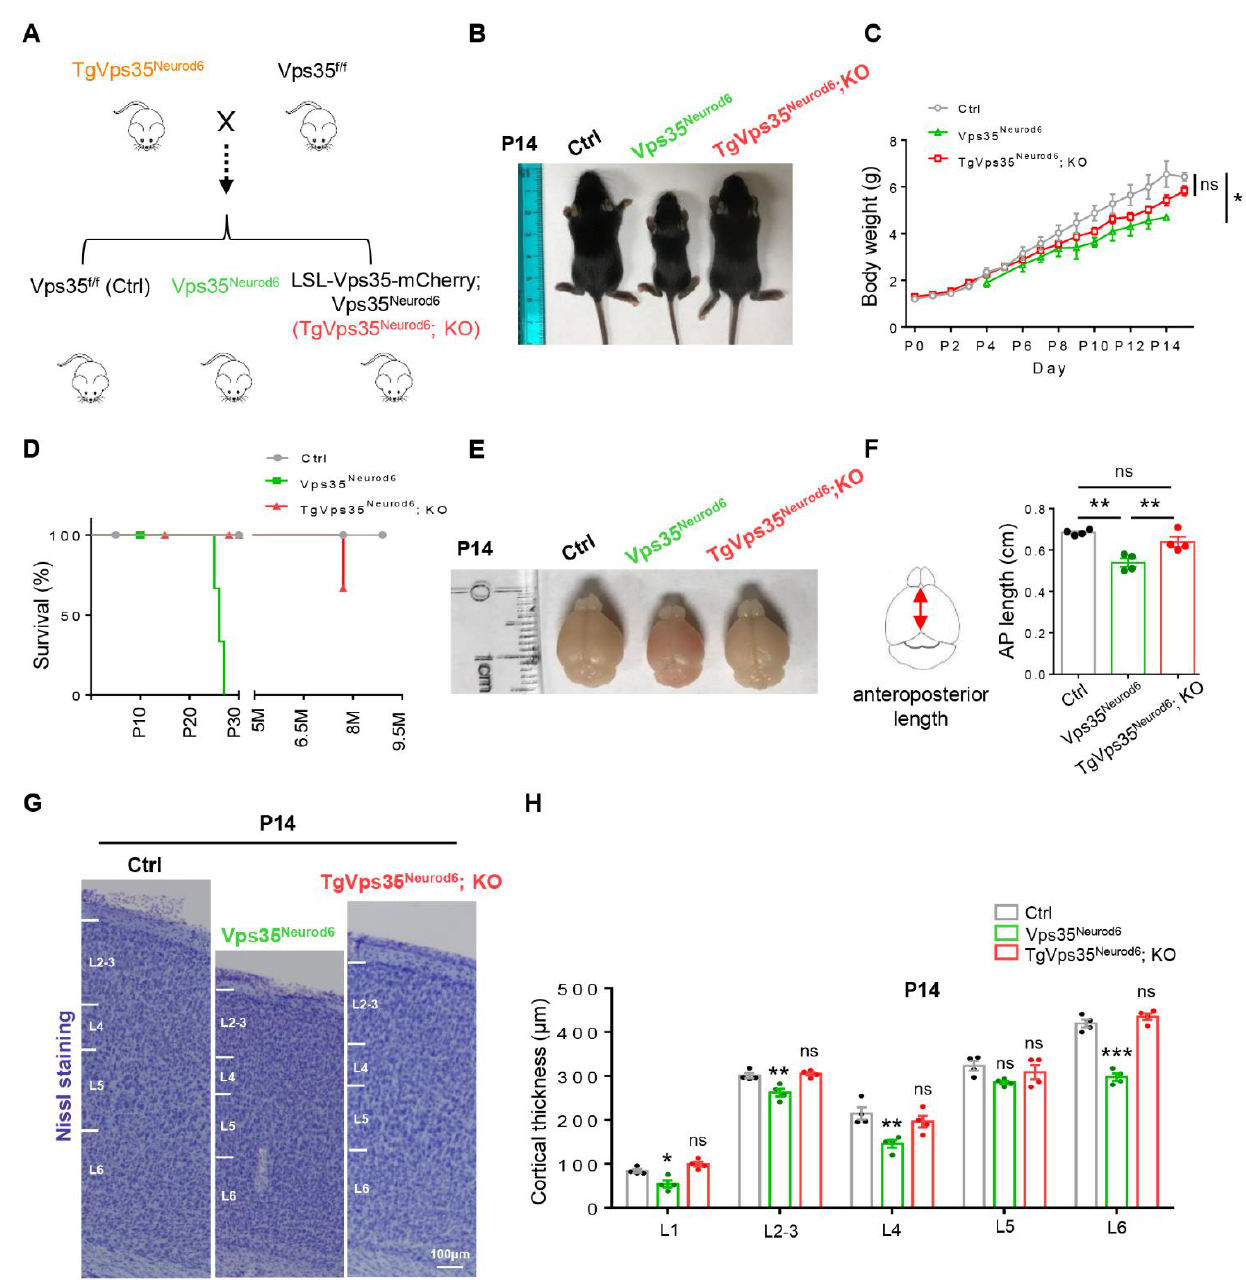
Figure 1. Generation of TgVps35 Neurod6 ; KO mice. ( A ) TgVps35 Neurod6 mice were crossed with Vps35 f/f mice to generate TgVps35 Neurod6 ; KO mice. ( B ) TgVps35 Neurod6 ; KO mice appeared indistinguishable from control littermates at P14. ( C , D ) Body weight and Kaplan-Meier survival curves of TgVps35 Neurod6 ; KO mice, Vps35 Neurod6 mice and littermate controls. ( E ) Representative images showing the brain size of control, Vps35 Neurod6 and TgVps35 Neurod6 ; KO mice at P14. ( F ) Quantification of the brain size ( n = 4 mice per group; one-way ANOVA with Tukey’s multiple-comparison test). ( G ) Representative Nissl staining of control, Vps35 Neurod6 and TgVps35 Neurod6 ; KO mice at P14. ( H ) Quantification analysis of Nissl staining that revealed a comparable cortical thickness of TgVps35 Neurod6 ; KO mice compared with those of control mice ( n = 4 animals per genotype; one-way ANOVA with Tukey’s multiple-comparison test). Scale bars as indicated in each panel. Individual data points were shown as dots with group mean ± S.E.M; * p < 0.05; ** p < 0.01; *** p < 0.001; n.s.: Not significant.